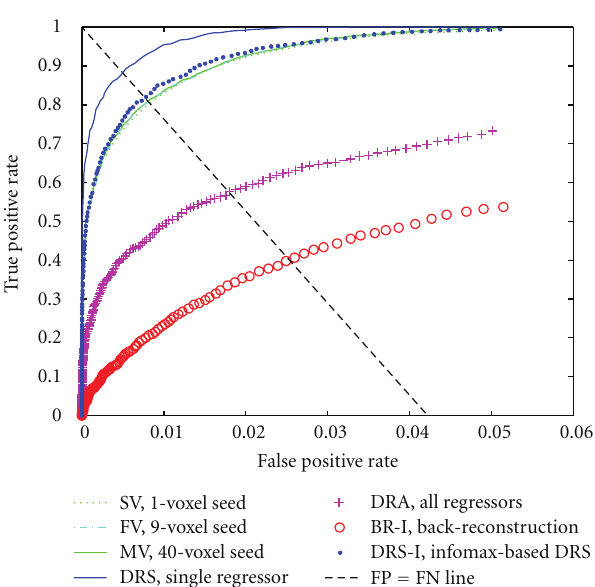
Figure 7: ROC curves for Subject 1, on the interval from 0 to 0.05. Subject 1’s task-related, GLM-derived spatial map was used as the “true” standard of comparison. The points where the number of false positives (FPs) was equal to the number of false negatives (FNs) fall along the FP = FN line shown above. This helps to explain why the results of the ROC PAUC analyses (Experiments 3–5, Criterion 5) were so similar to the results of the threshold-adjusted overlap analyses (Experiments 3–5, Criterion 4).